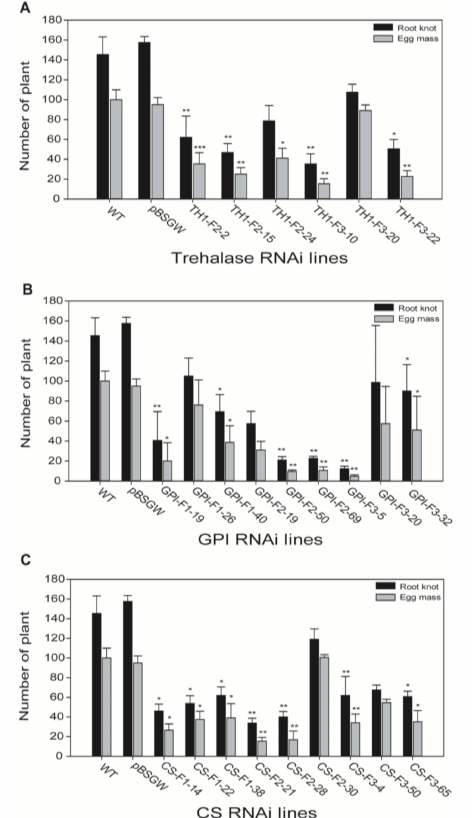
Figure 4. Numbers of root knots and egg masses per RNAi transgenic plant infected with M . incognita . ( A ) Trehalase 1 RNAi lines, ( B ) GPI RNAi lines, and ( C ) CS RNAi lines. WT, wild type; pBSGW, control vector. Each bar represents the mean ± standard deviation (SD) of three independent experiments with three technical replicates. Statistical analyses ( t -test) were conducted using SigmaPlot 12.5. For t -test analysis, WT data infected by nematode were used to compare with each RNAi line. Asterisk indicates significant di ff erences compared with wild-type, * p < 0.05, ** p < 0.001, *** p <